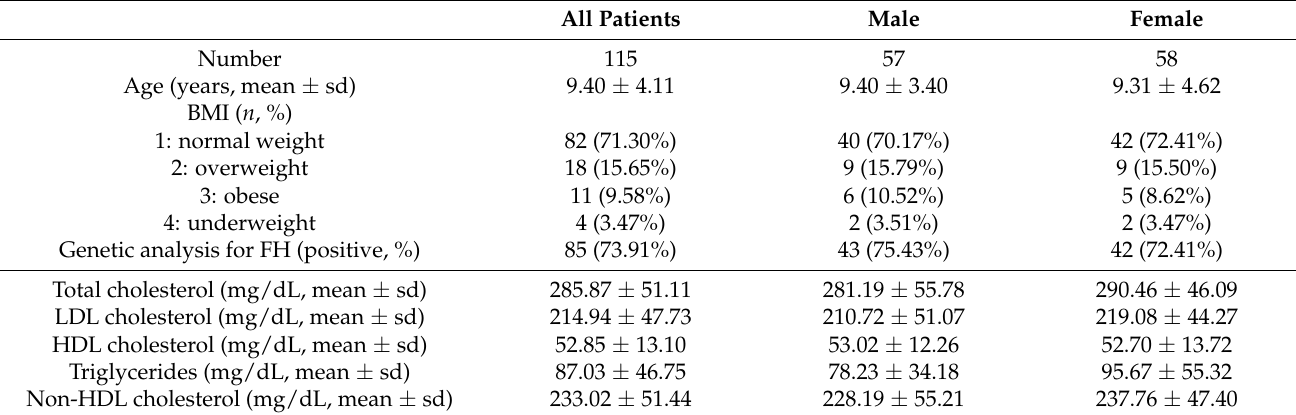
Table 1. General characteristics of the study